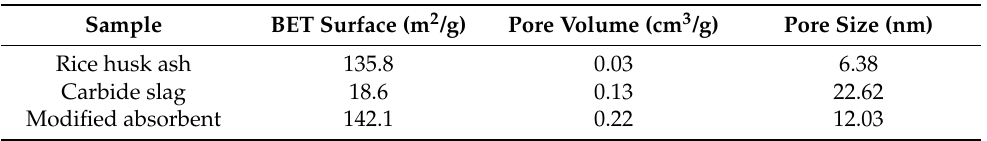
Table 3. Specific surface area and pore structure characteristics of rice husk ash, carbide slag and modified